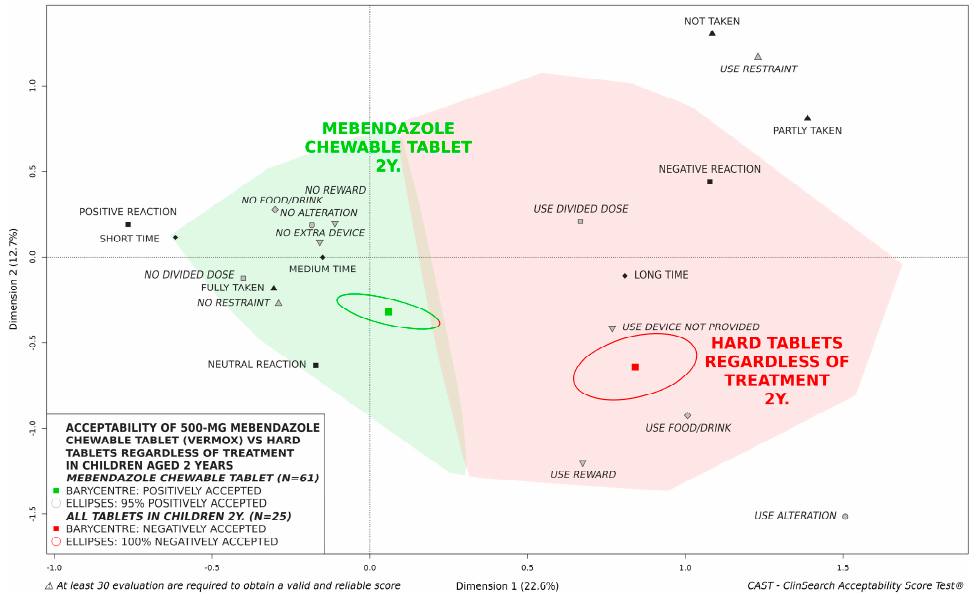
Figure 4. Acceptability of 500-mg mebendazole chewable tablet compared to tablets regardless of treatment in children aged 2 years.